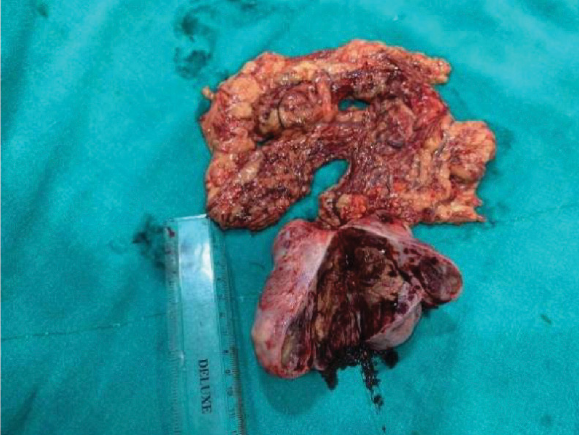
Figure 3A: Right Ovarian mass measuring 10 x 8 cm with mild peritoneal adhesion